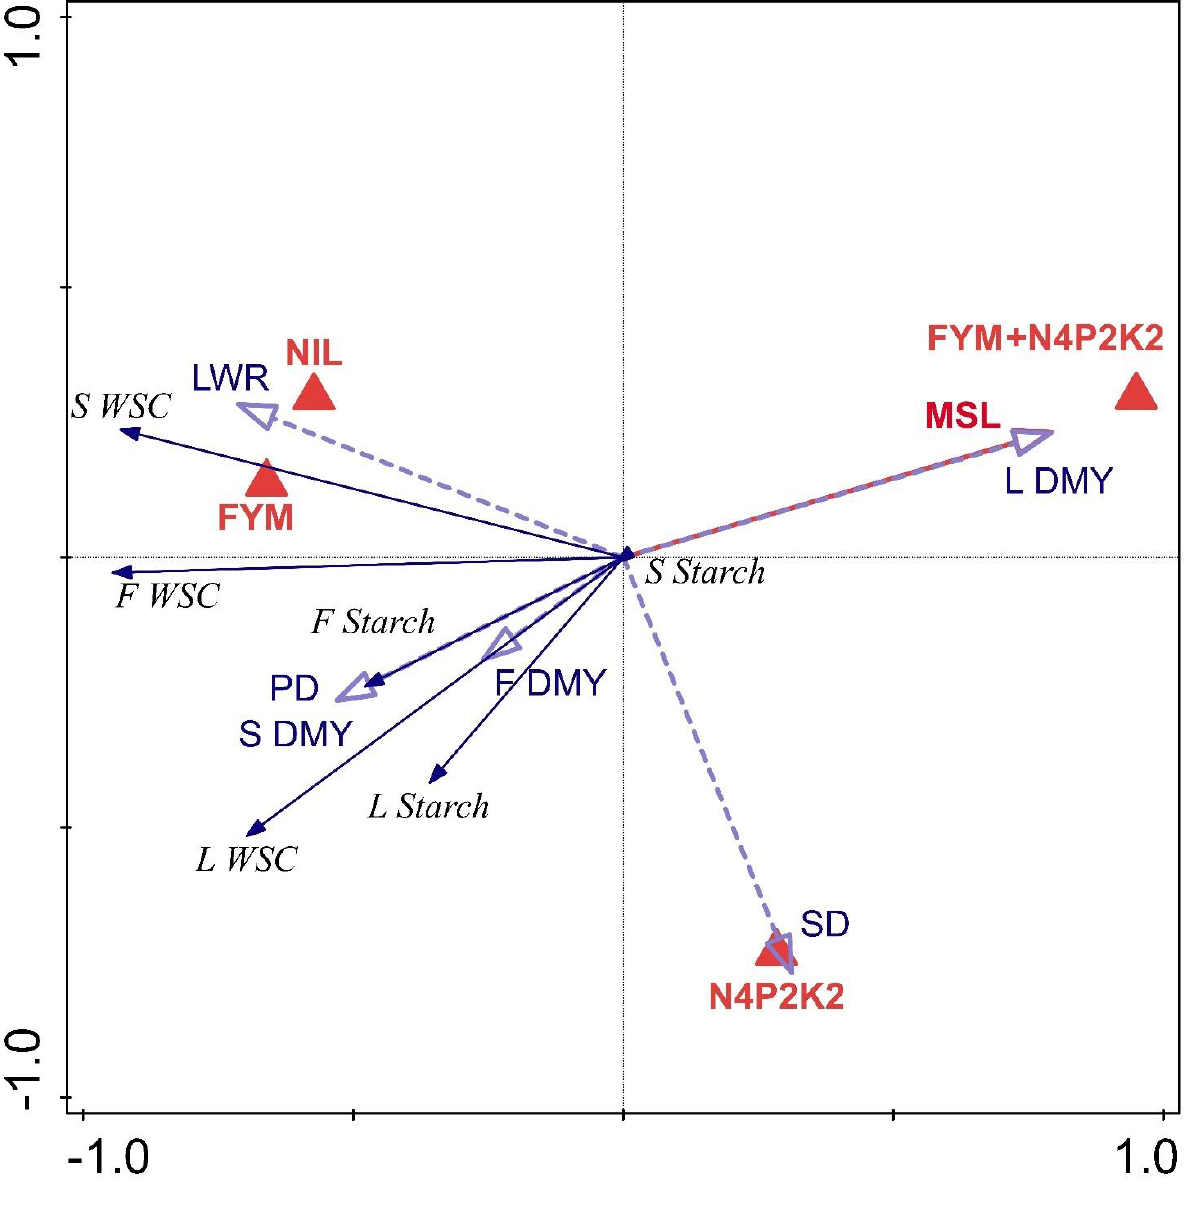
Figure 2. Ordination biplot showing the relationship between lucerne WSC and starch concentration (dependent variables, black solid line arrows) and explanatory variables considering fertilization treatments (triangle labels) and maximal stem length (red arrow) with respect to supplementary variables of canopy traits (broken line arrows). Abbreviations: DMY = dry matter yield of sample, F = variable related to whole forage, FYM = farmyard manure, L = variable related to leaf fraction, LWR = leaf weight ratio, MSL = maximal stem length of lucerne stem in the sample, NIL = unfertilized control, N4P2K2 = mineral fertilization, PD = plant density, S = variable related to stem fraction, SD = stem density, WSC = water-soluble carbohydrates.